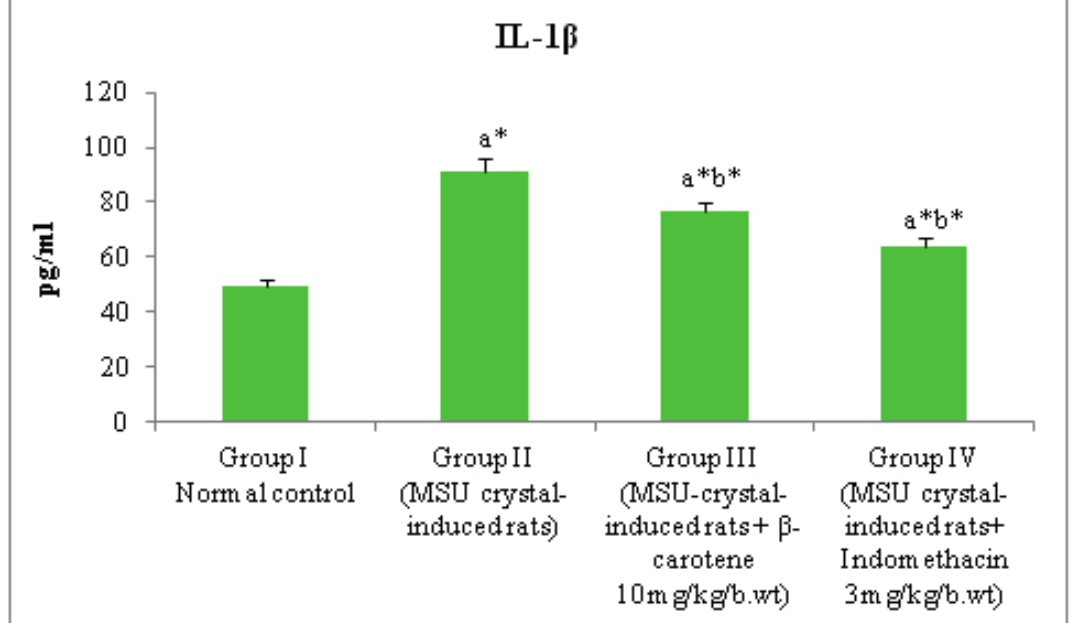
FIGURE 6 - Effect of β -carotene on serum IL-1 β of MSU crystal-induced arthritis N=6 animals in each group. The values are expressed as mean ± S.D. Comparisons indicated by lower case letters were made as follows: a – group I vs. group II, III and IV; b – group II vs. group III and IV; c – group III vs. group IV. Statistical analysis was carried out by one way ANOVA followed by Student’s Newman – Kuel’s test. The symbols represent statistical significance at: * p <